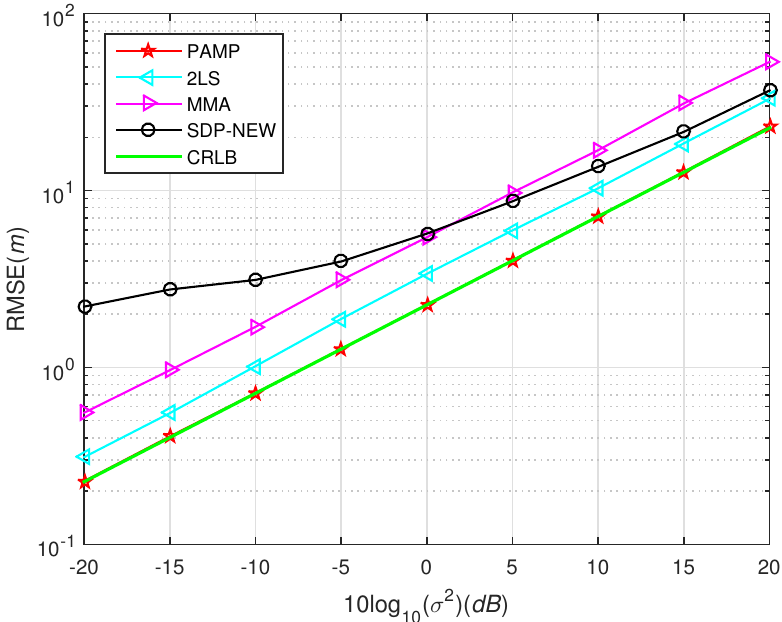
Figure 5. RMSE versus σ 2 using different methods, far-field case in scenario 1.